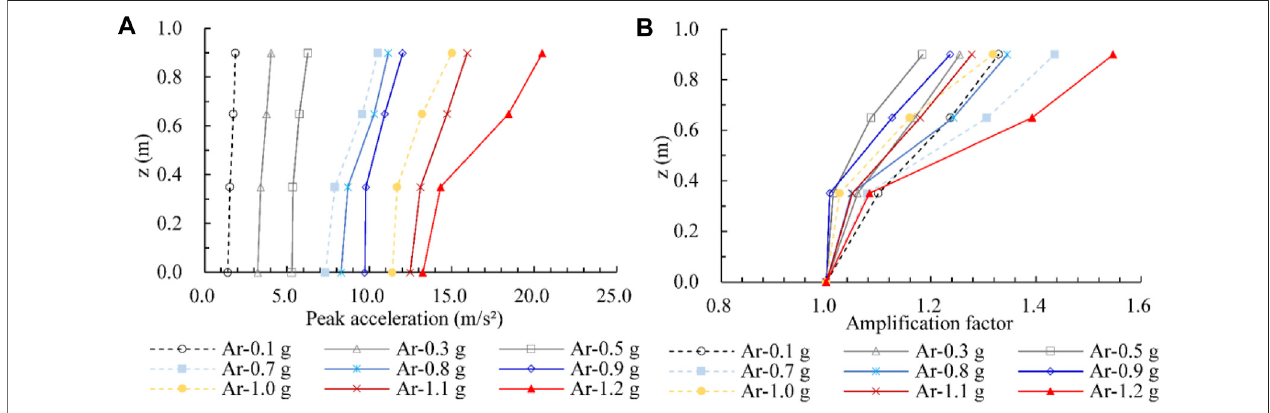
FIGURE 8 | Peak acceleration response curves for various depth. (A) Peak acceleration versus depth, (B) acceleration ampli fi cation factor versus depth.